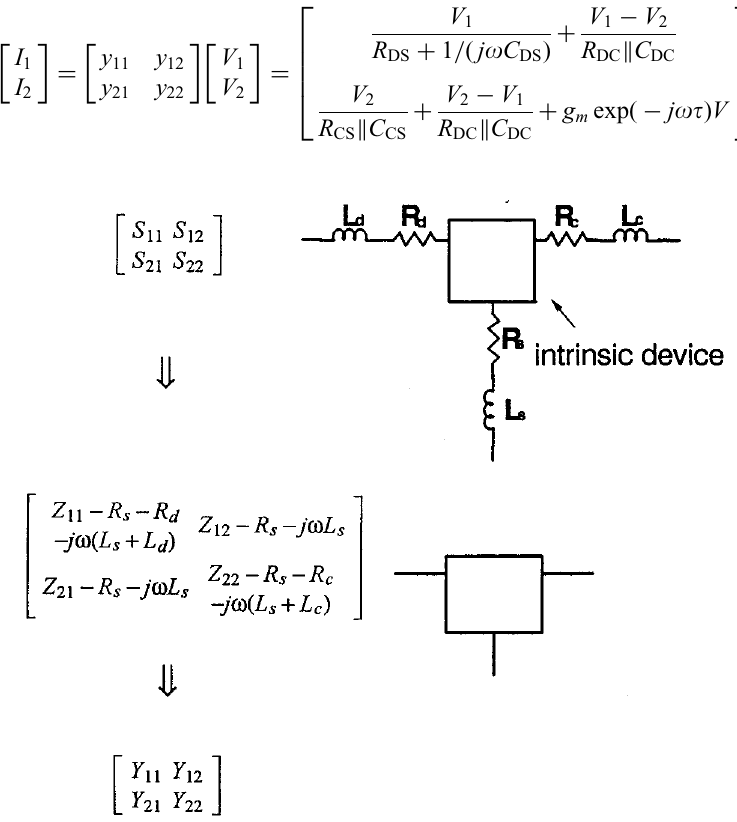
FIGURE 5 The procedure for extracting the intrinsic